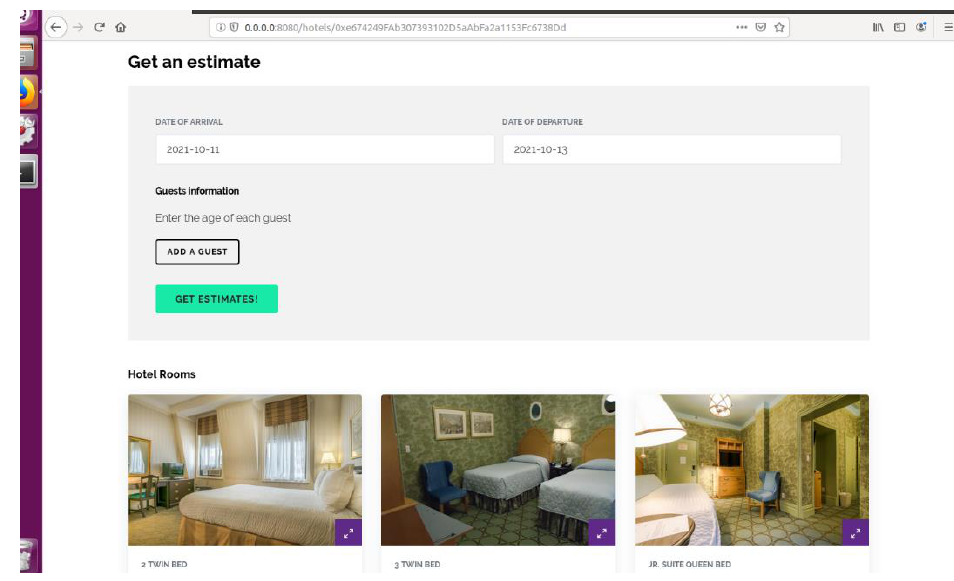
Figure 25. The client searches for hotel information.